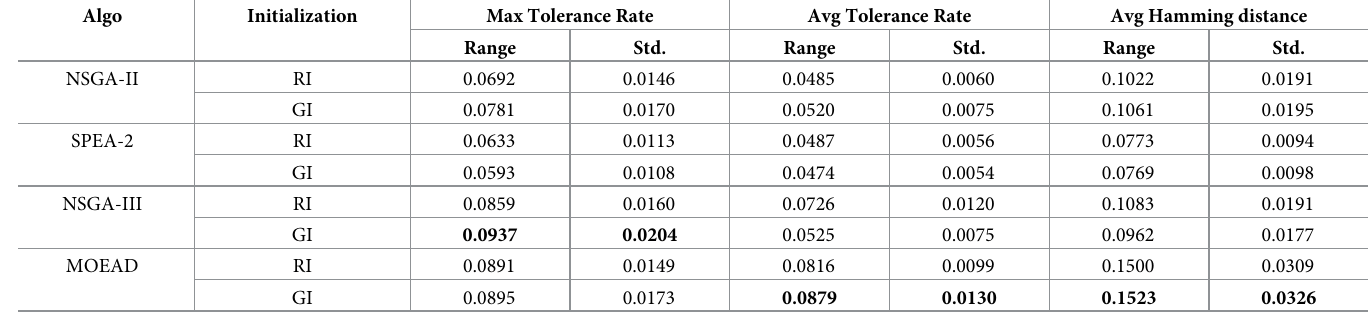
Table 5. Performance comparison of algorithms using measures of maximum tolerance rate, average tolerance rate, and average hamming distance. GI stands for greedy initialization, RI stands for random initialization.